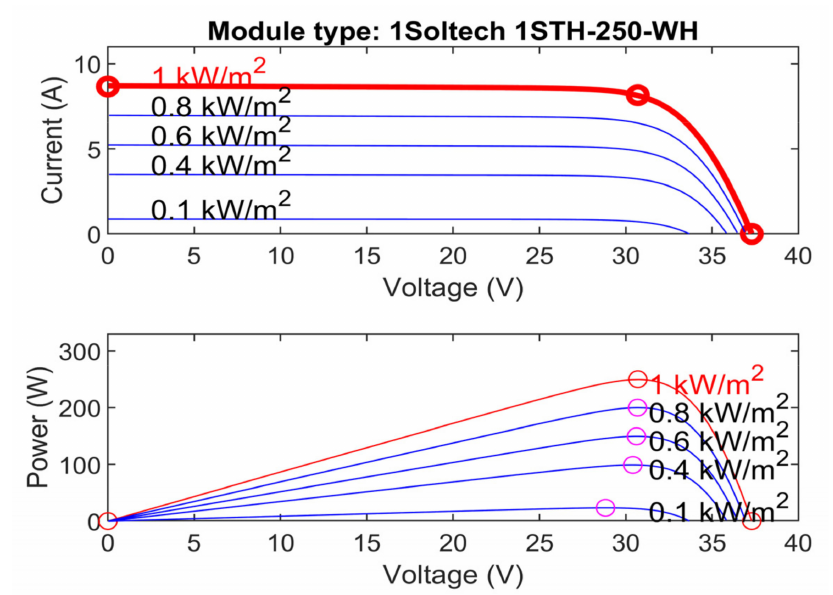
Figure 3. I-V, P-V curves for various irradiations at 25 ◦ C.